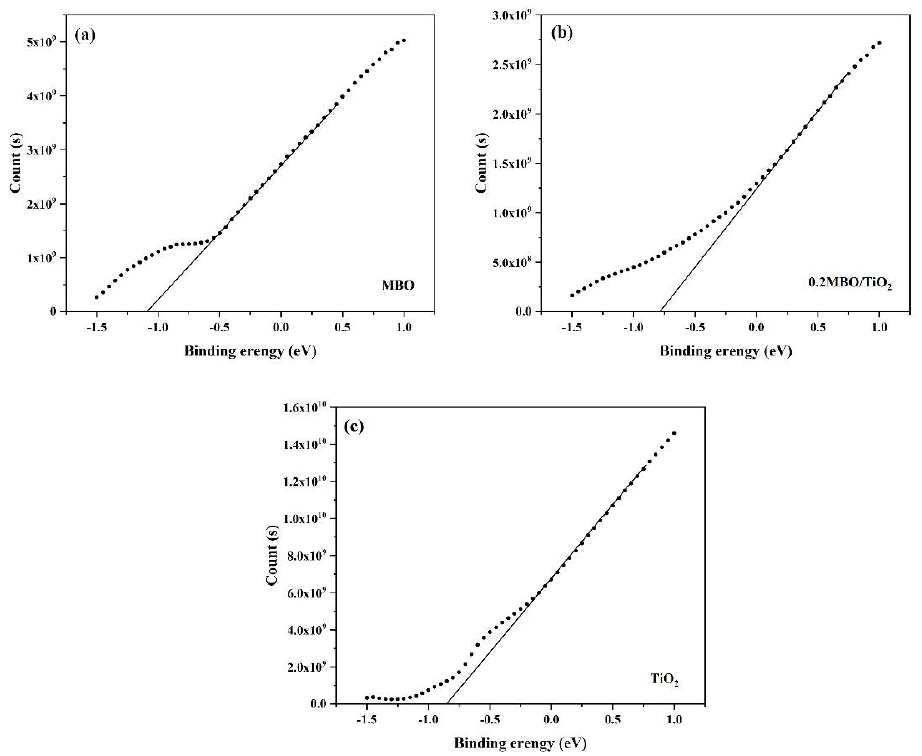
Figure 8. Mott–Schottky plots for ( a ) MBO, ( b ) 0.2 MBO/TiO 2 and ( c ) TiO 2 . The potential mechanism of photocatalytic hydrogen production for MBO/TiO 2